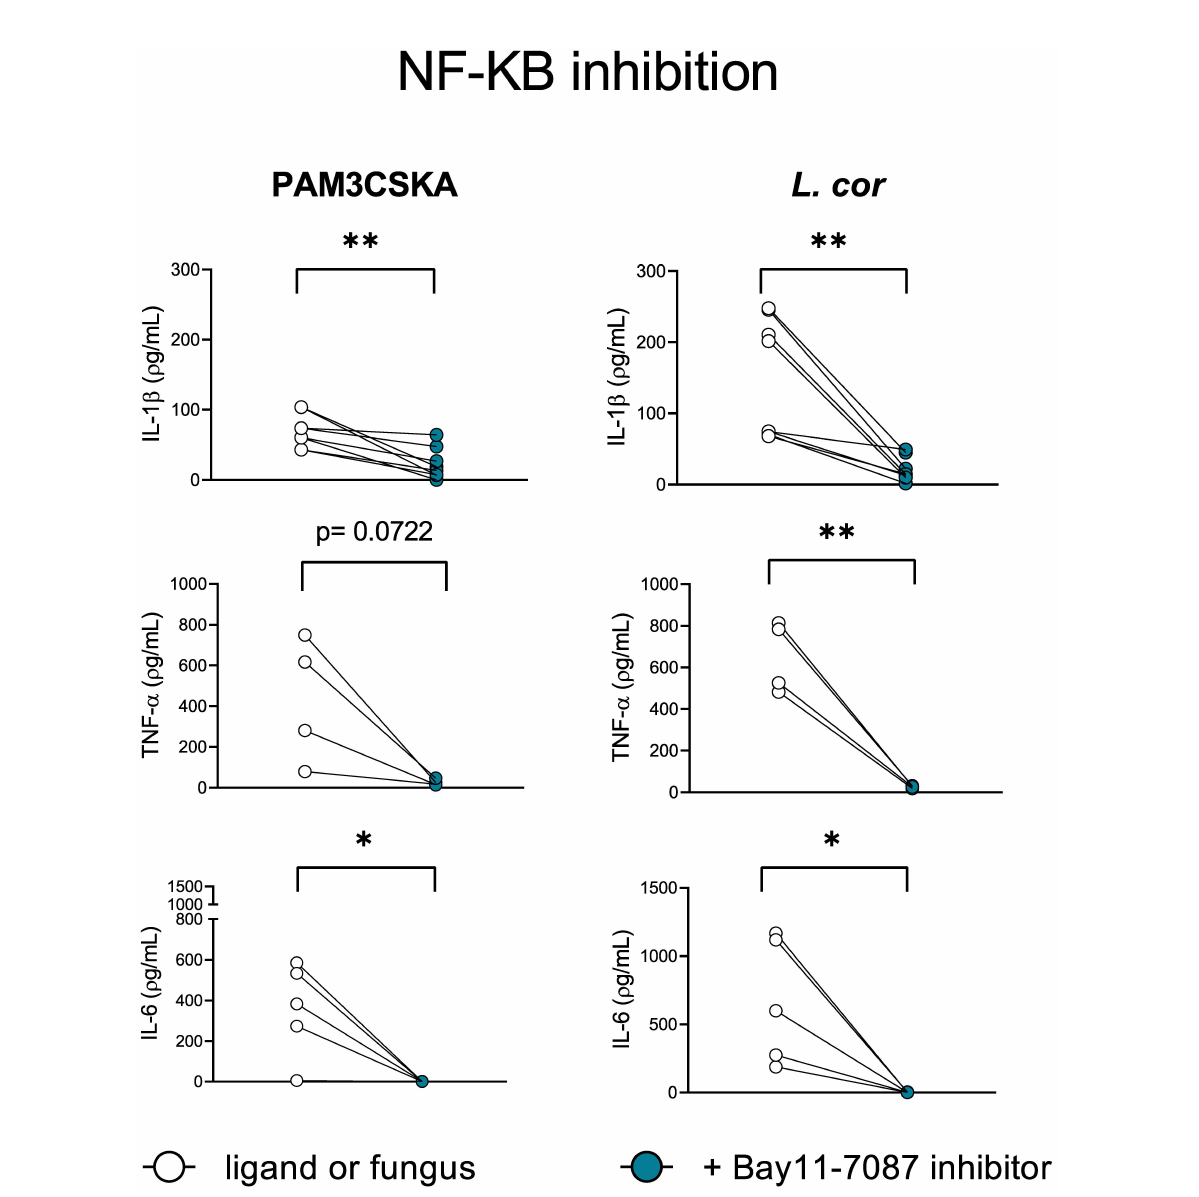
FIGURE 7 NF-kB is a central mediator of the in fl ammatory response during infection with L. corymbifera . Monocytes were incubated for three hours with the NF-KB inhibitor (Bay11-7087), before infection with L. corymbifera for sixteen hours. Pro-in fl ammatory cytokines were measured by ELISA. Dots and lines represent paired values of every single donor. Data were obtained from three independent experiments, each with two or three different donors, and differences among groups were assessed by paired t-test. * p < 0,05; ** p <0,01. L corymbifera (L.